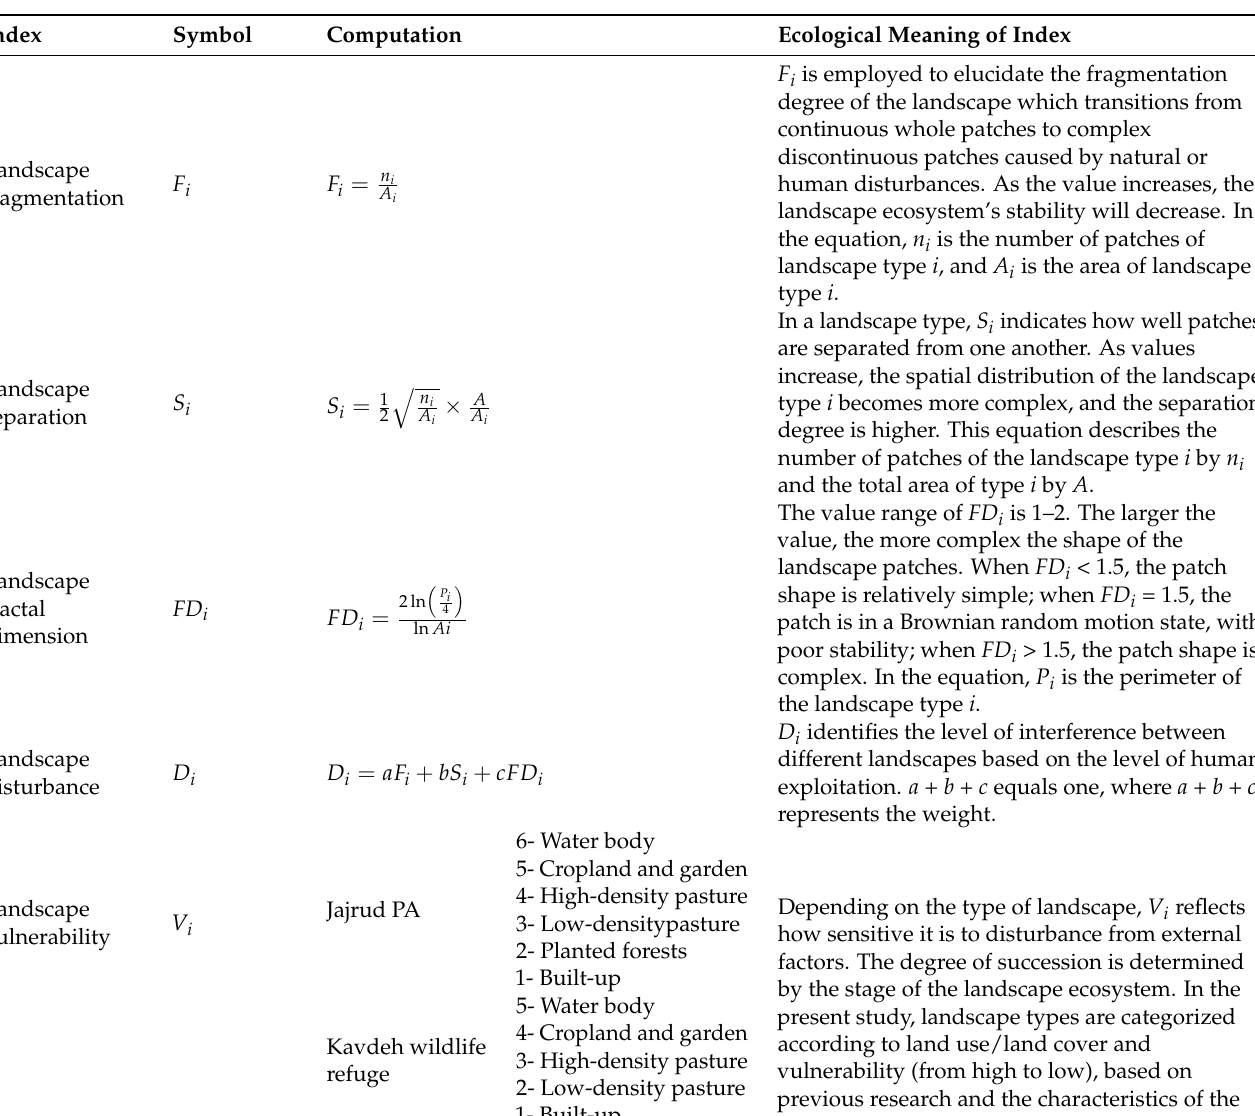
Table 2. Ecological meaning and calculation of the landscape index (adapted from Zhang et al.,